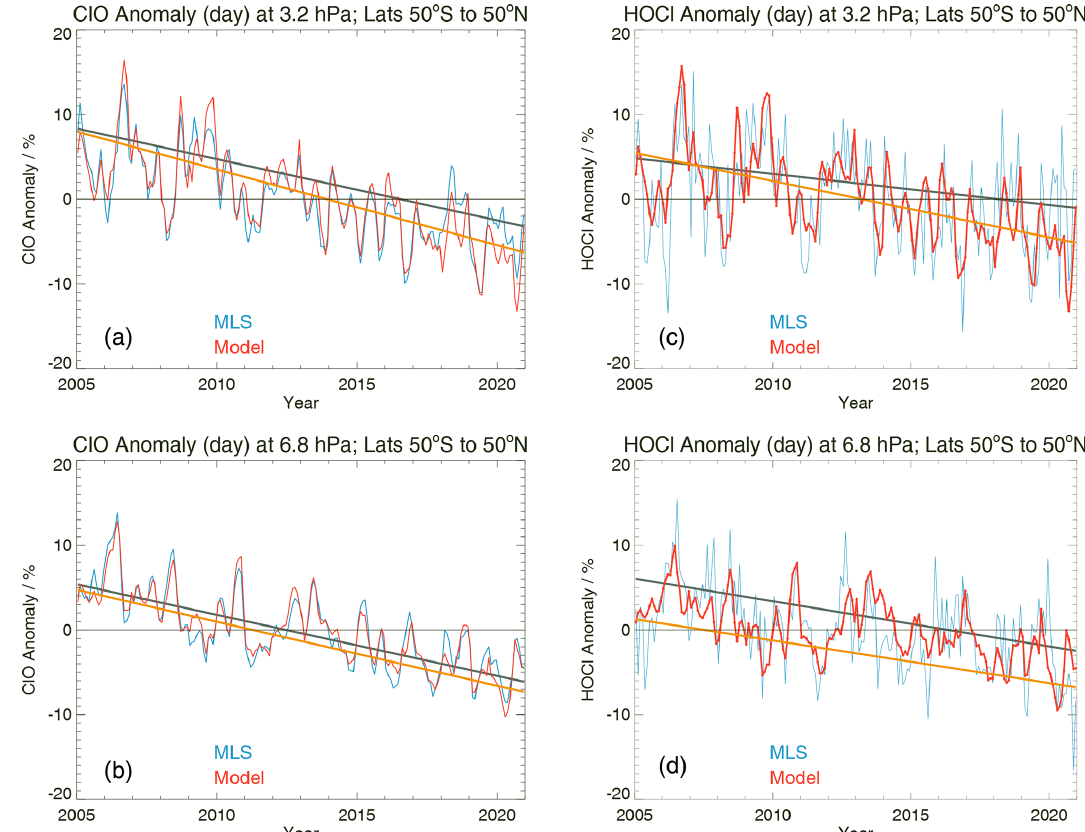
Figure 11. Deseasonalized anomaly time series (percent) of MLS (blue) and WACCM (red) 50 ◦ S–50 ◦ N averages over the period 2005 through 2020 for (a) ClO at 3.2hPa, (b) ClO at 6.8hPa, (c) HOCl at 3.2hPa, and (d) HOCl at 6.8hPa. The linear components of the multivariate linear regression fits are given by dark gray and orange lines for MLS and WACCM, respectively. The associated percent residuals are provided in Fig.